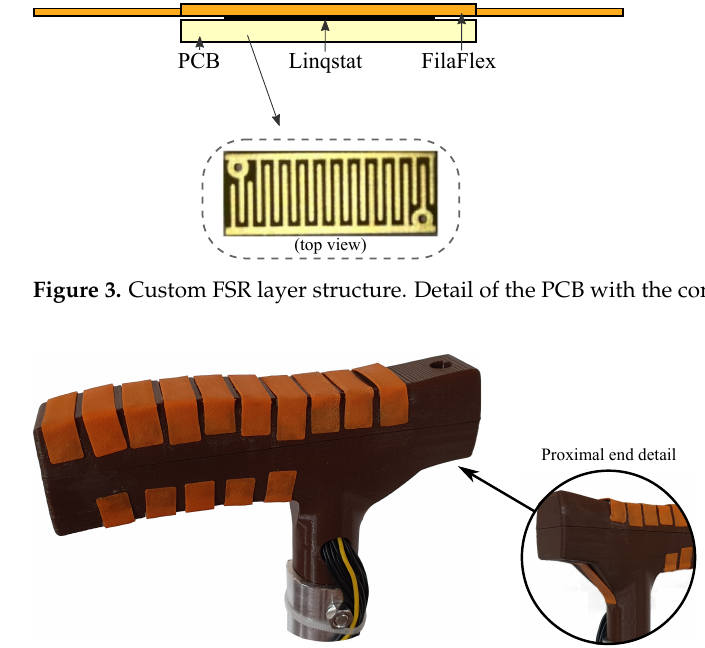
Figure 4. Custom handle